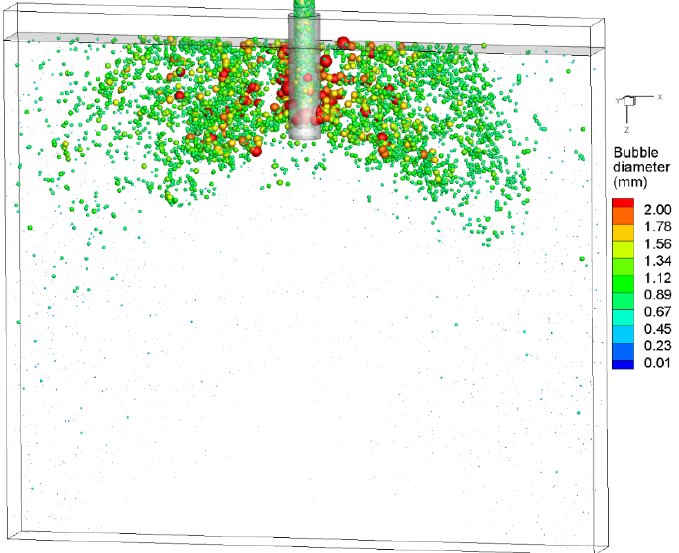
Figure 9. Spatial distribution of bubbles at t = 90 s.